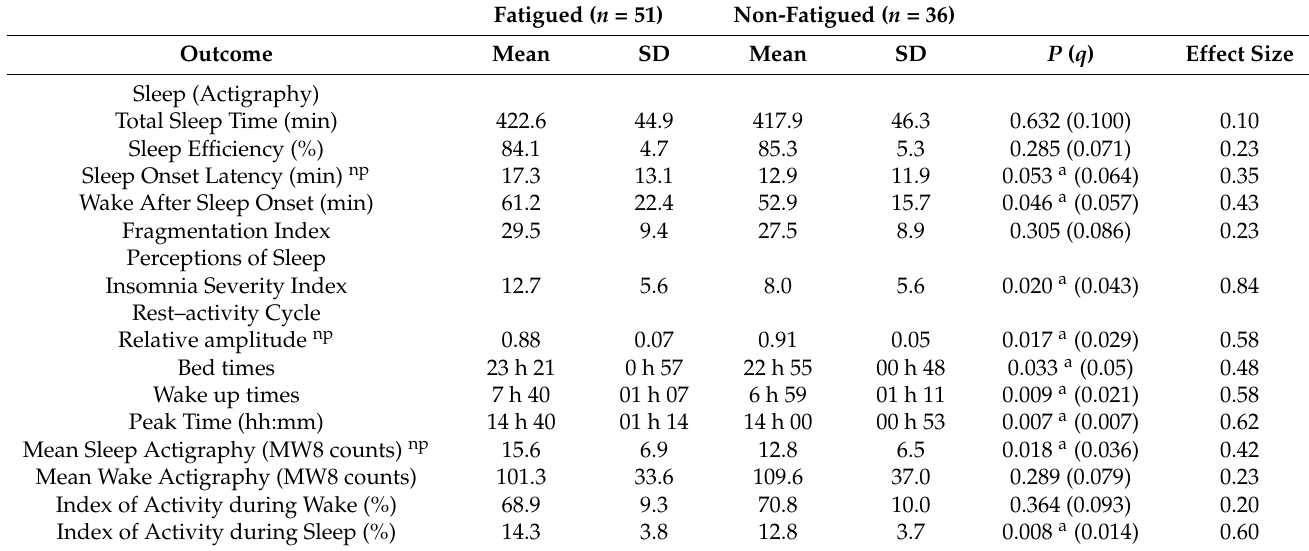
Table 2. Sleep and rest–activity cycle parameters for fatigued and non-fatigued cancer